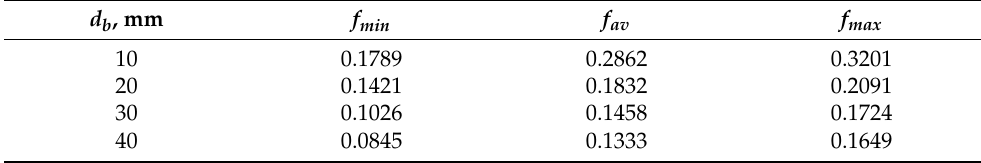
Table 3. Minimum, average, and maximum values of the f parameters depending on the bar diameter. d b ,